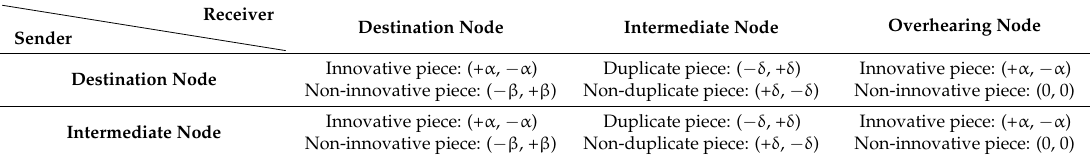
Table 3. Guidelines to modify credit values and stimulate incentives for four types of